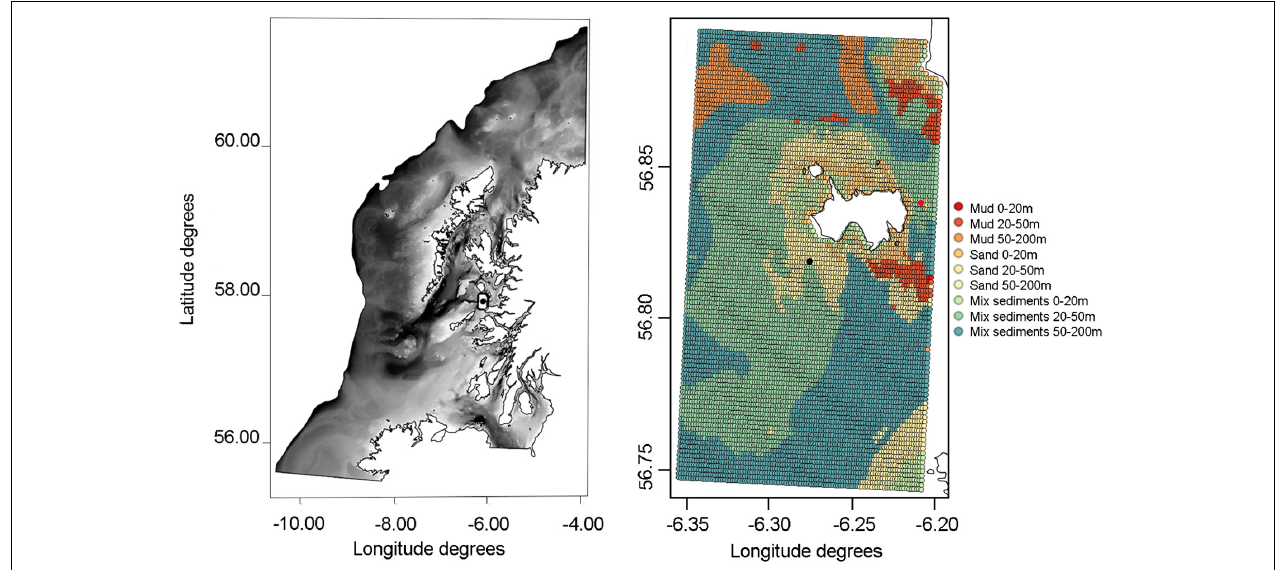
FIGURE 2 | ICES VIa area, showing the continental shelf bathymetry map (up to 200 m depth profile; extracted from https://www.gebco.net/) and the sediment composition around Isle of Muck, the existing operational fish farm (red dot), the Multi-Purpose Platform (MPP) site (black dot) and the Ecospace model domain (black